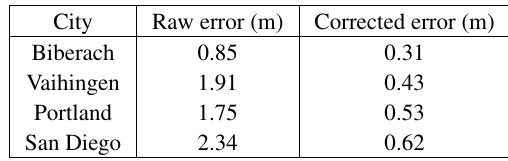
Table 2. Geometric error for each